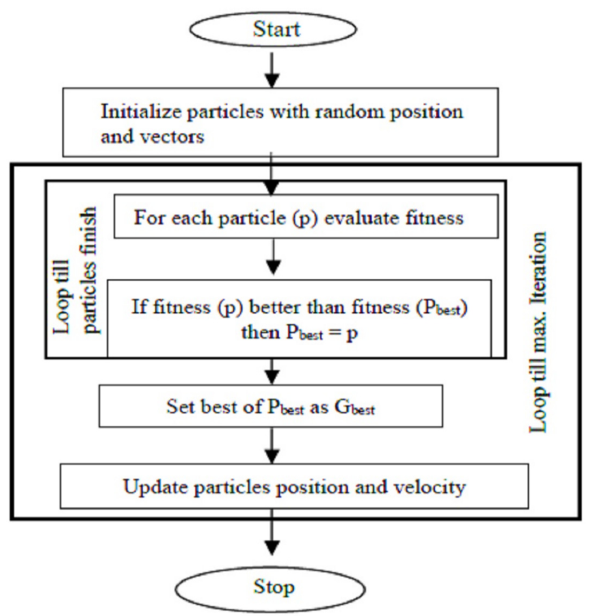
Figure 8. PSO Flowchart.